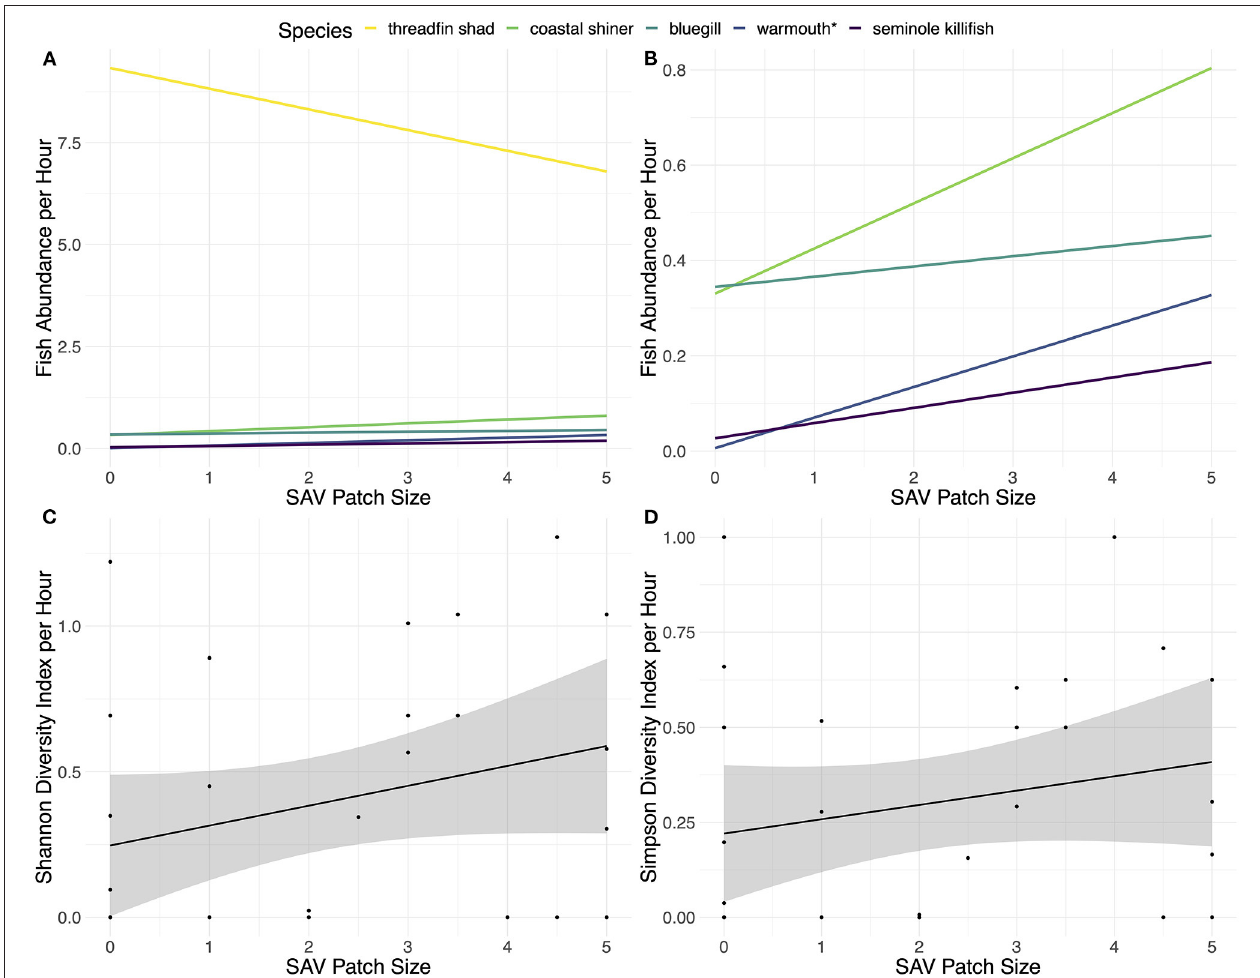
FIGURE 2 | (A) Fish abundances of the five fish species caught in more than one fyke net, (B) fish abundances of the fish species caught in more than one fyke net excluding threadfin shad, (C) Shannon diversity index of all the species caught, and (D) Simpson diversity index of all the species caught. All graphs were based on catch-per-hour caught in fyke nets plotted against size of SAV patch with the linear model method. SAV patch sizes were estimated based on an index of 0–5, with 0 being a bare habitat and each increase of 0.5 in the index being equivalent to an approximated increase in patch size of 0.75 by 0.75m. The fish species in the legend are listed in the order they appear on the right side (A)